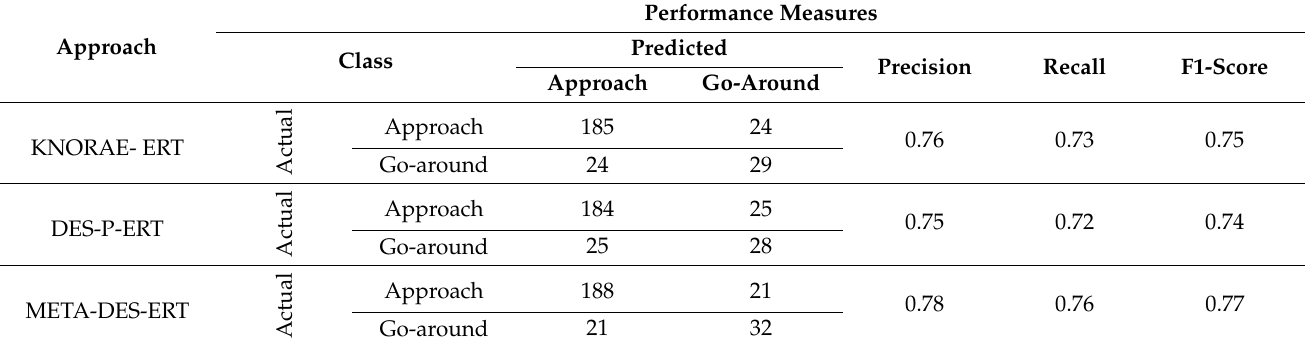
Table 9. Comparison of performance measures of DES based on the pool of ERT.